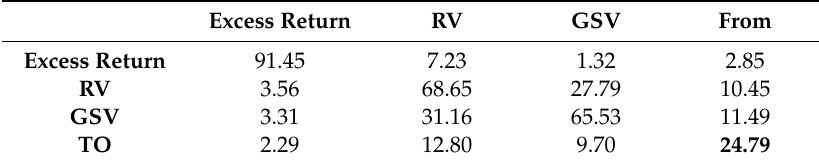
Table 5. Total spillover, Hungary.